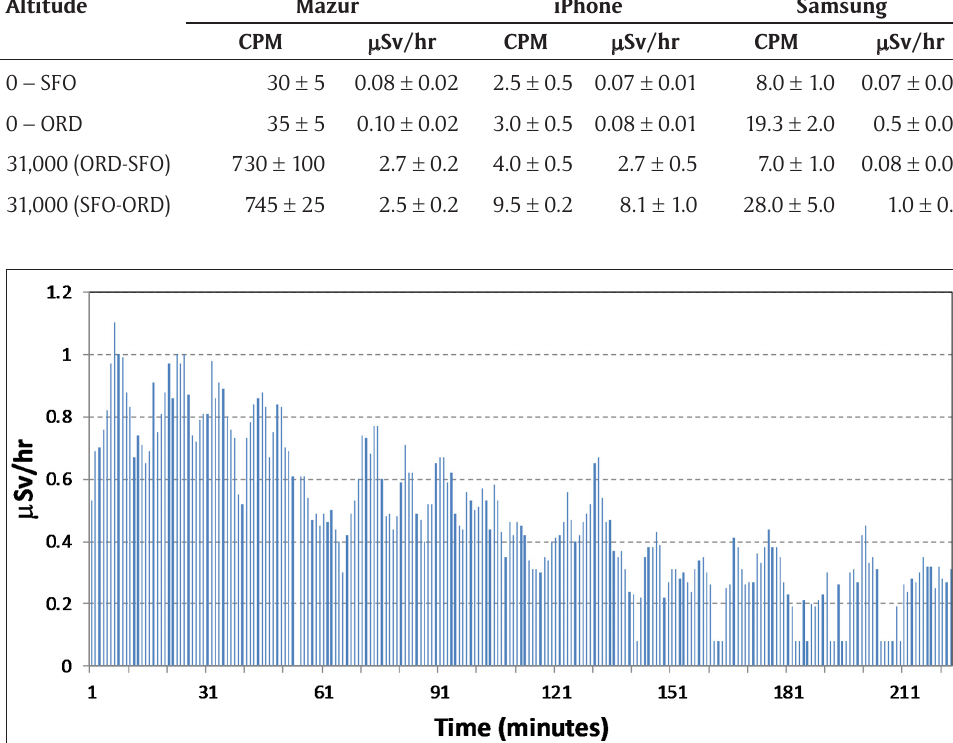
Table 3: Flight measurements and platform comparisons with the back camera. Altitude Mazur